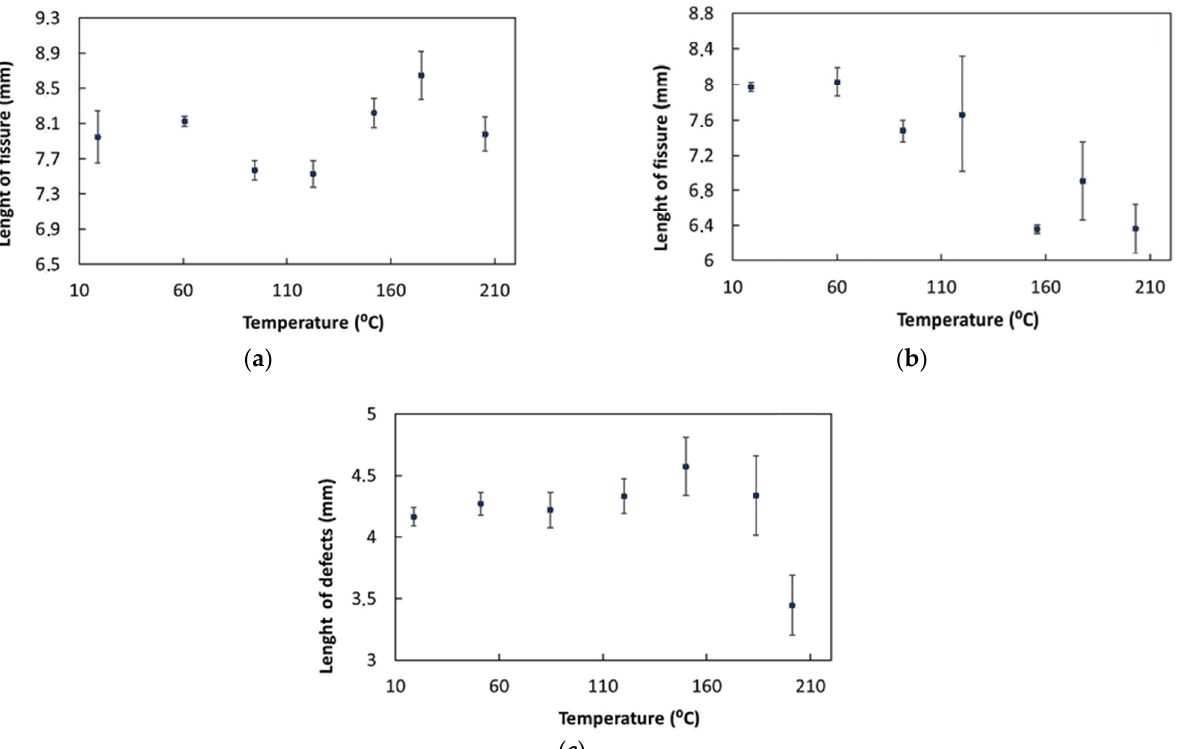
Figure 9. Variation of the maximum amplitude with the temperature for different defects.